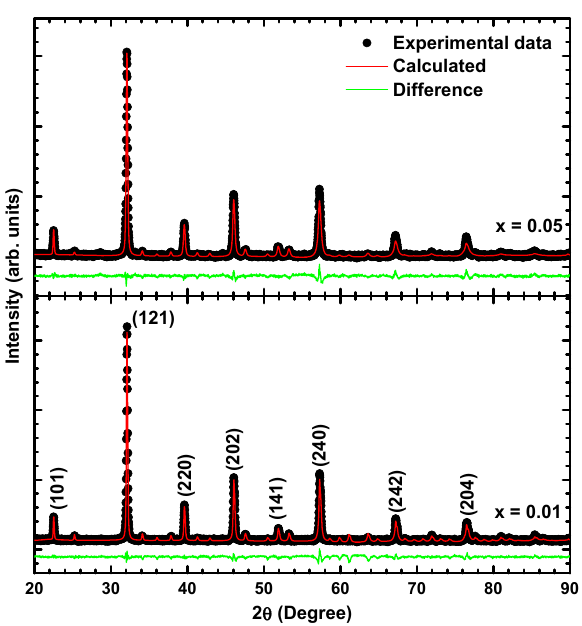
Figure 1. XRD pattern of LaFe 1 − x Zr x O 3 annealed at 800 °C for 6 h. Table 1. Crystallographic parameters of the LaFe 1 − x Zr x O 3 annealed at 800 °C for 6 h, obtained by the FullProf 2k programme.